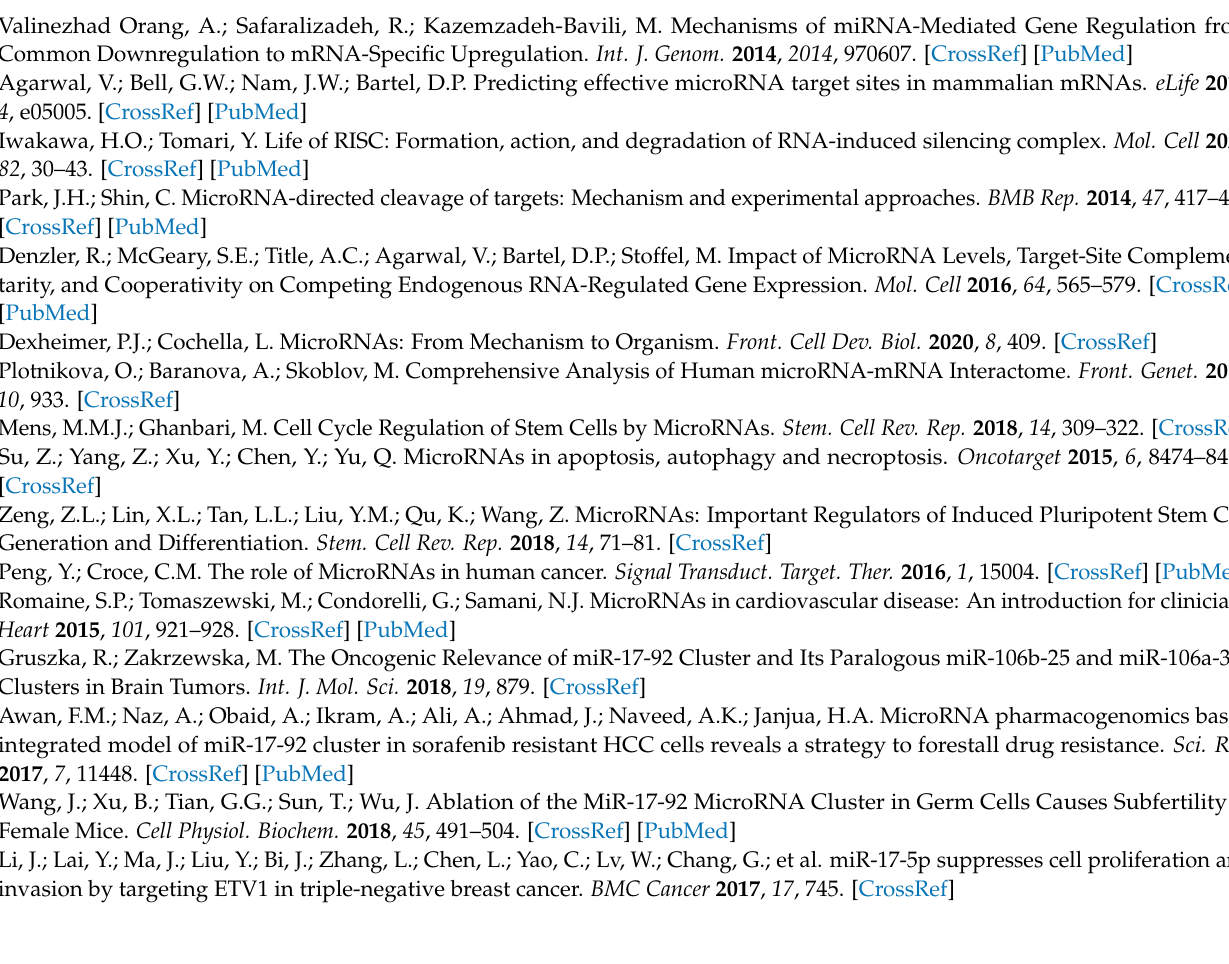
CAAAGUGCUUACAGUGCAGGUAG) target sequences; Figure S3: 12 selected miR-17-5p target genes; Figure S4: 4T1 cells were transfected with control oligo and miR-17-5p, and subjected to RT- PCR; Figure S5: Real-time PCR using primers against 12 selected miR-17-5p target genes; Figure S6: HepG2 cells were transfected with control oligo and miR-17-5p, and subjected to RT-PCR; Figure S7: Upper, a control vector or PTEN coding sequence plasmid was transfected to breast cancer (MDA- MB-231), prostate cancer (DU145), and lung cancer cell lines (A549); Figure S8: Pearson correlation (a). Pearson correlation between relative increases of AGO2 mRNA and miR-17-5p in organs of transgenic mice was analyzed by Prism 8. Figure S9: Original blots of Figure